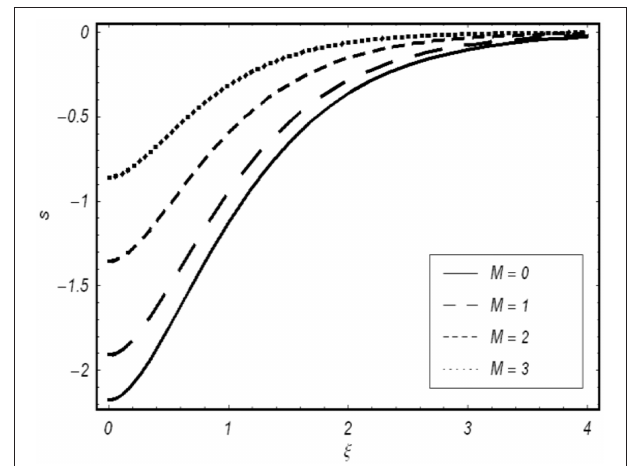
FIGURE 4 | Shear stress plots showing variations in M